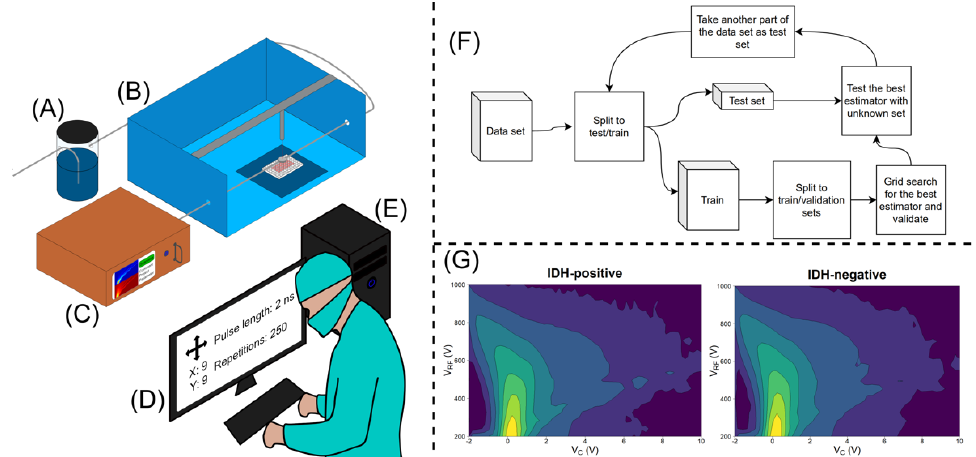
Figure 1. The setup: ( A ) humidifier; ( B ) sampling unit; ( C ) DMS analyzer ( D ); graphical user interface; ( E ) computing unit for data analytics; ( F ) workflow of the algorithm; ( G ) examples of IDH − positive and − negative dispersion spectra. Vc = compensation voltage; Vrf = peak-to-peak amplitude of the radiofrequency waveform voltage .